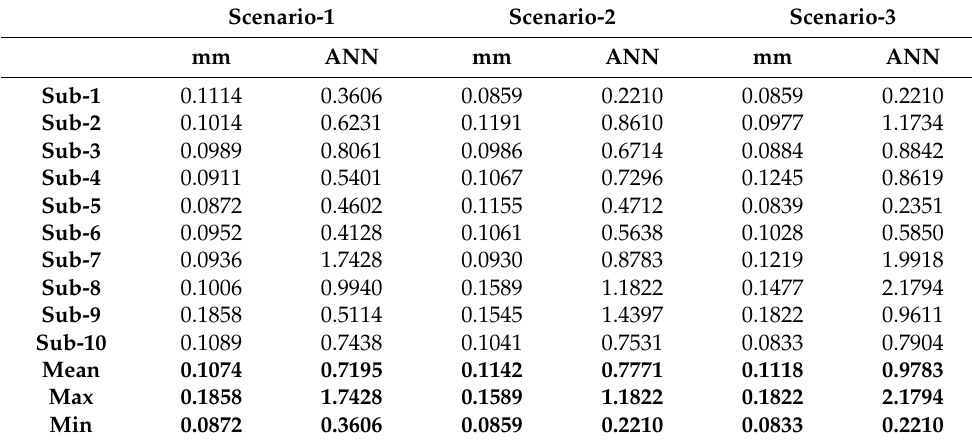
Table 4. Scenarios 1 to 4: evaluation of obtained results for ten subjects in terms of training computation (10 2 s).